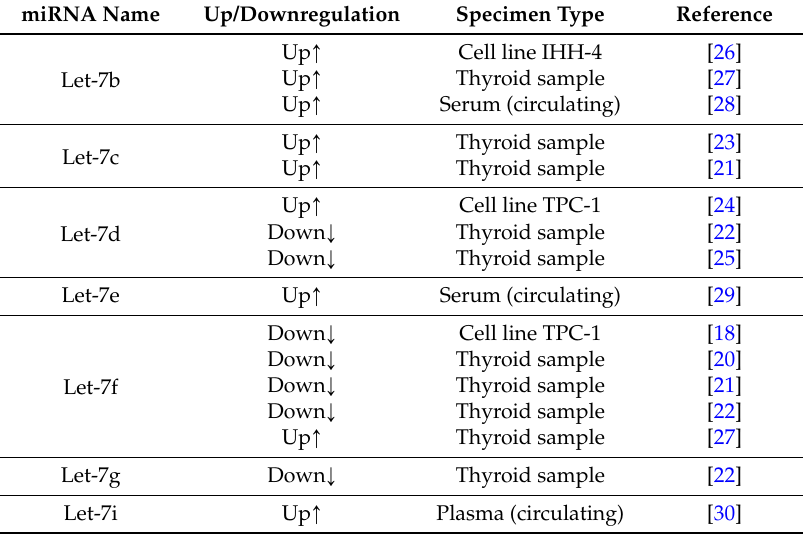
Table 1. miRNA characteristics of papillary thyroid cancer. TPC-1 human PTC cell line